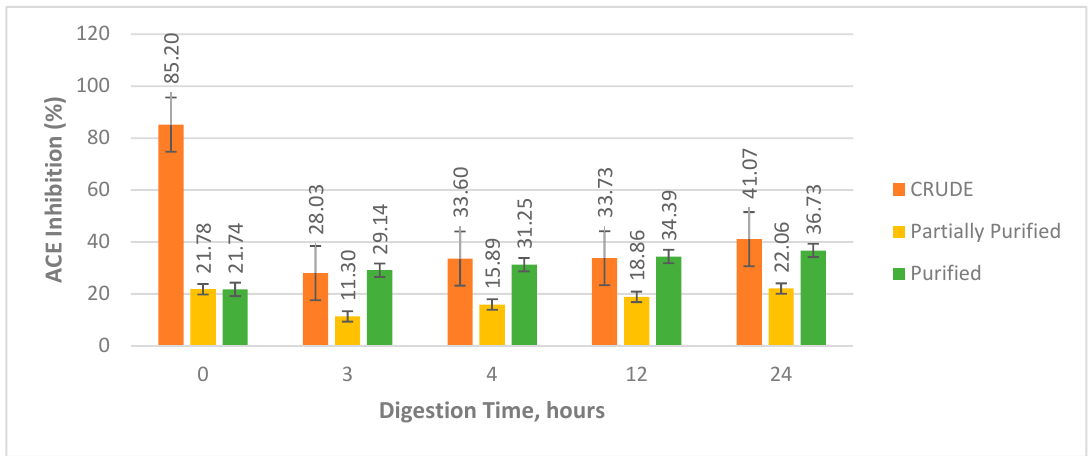
Figure 4. Comparison of ACE inhibition (%) of crude, partially purified and purified protein extracts at different digestion hours.